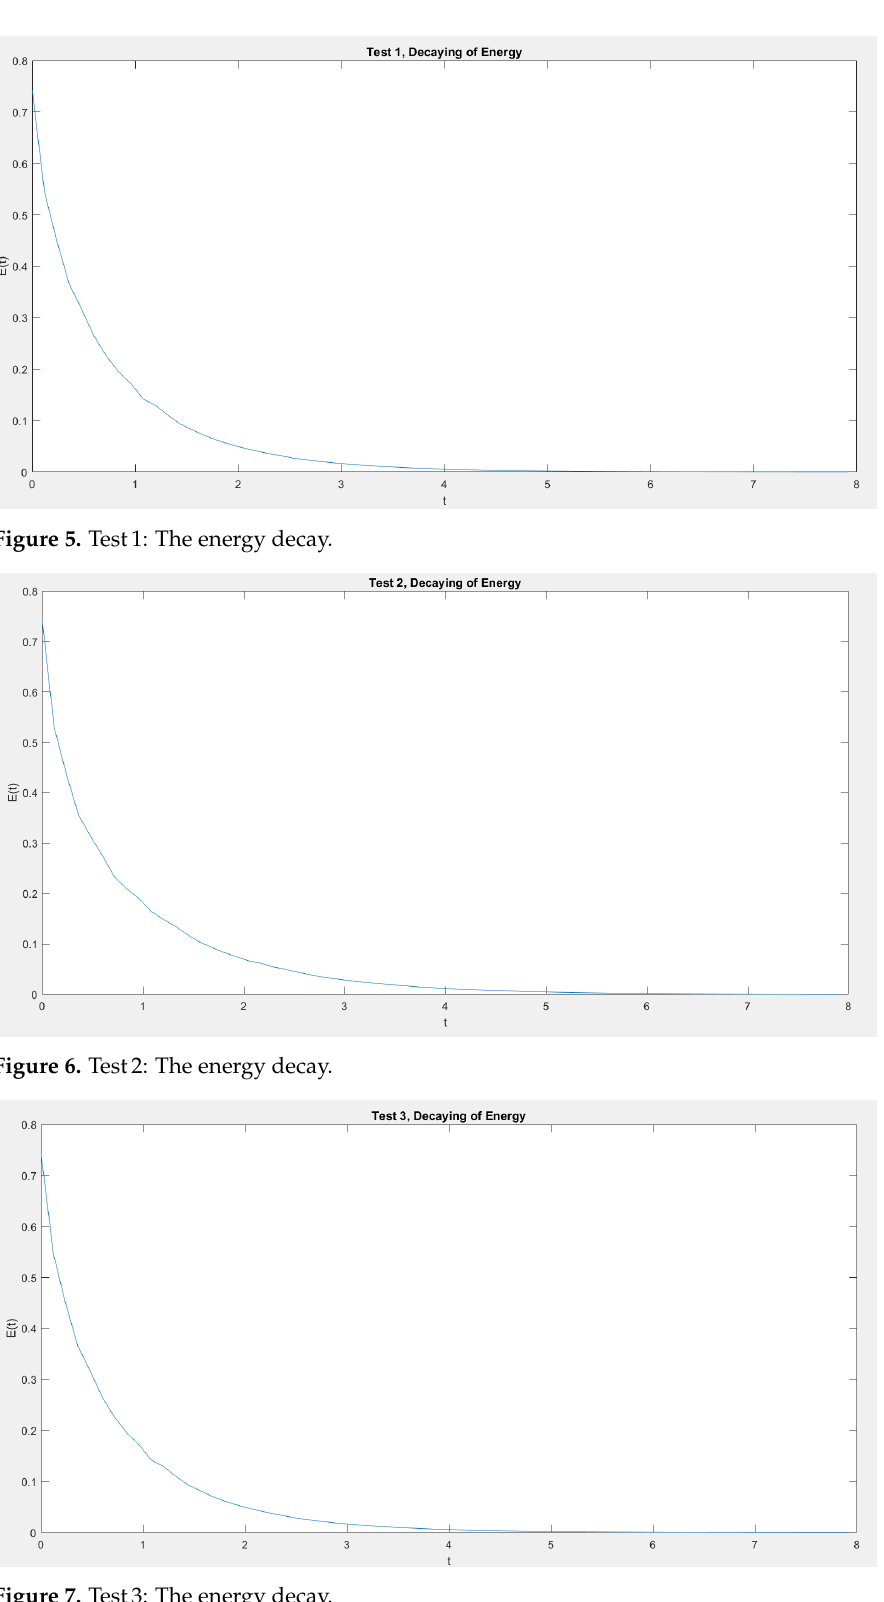
Figure 7. Test3: The energy